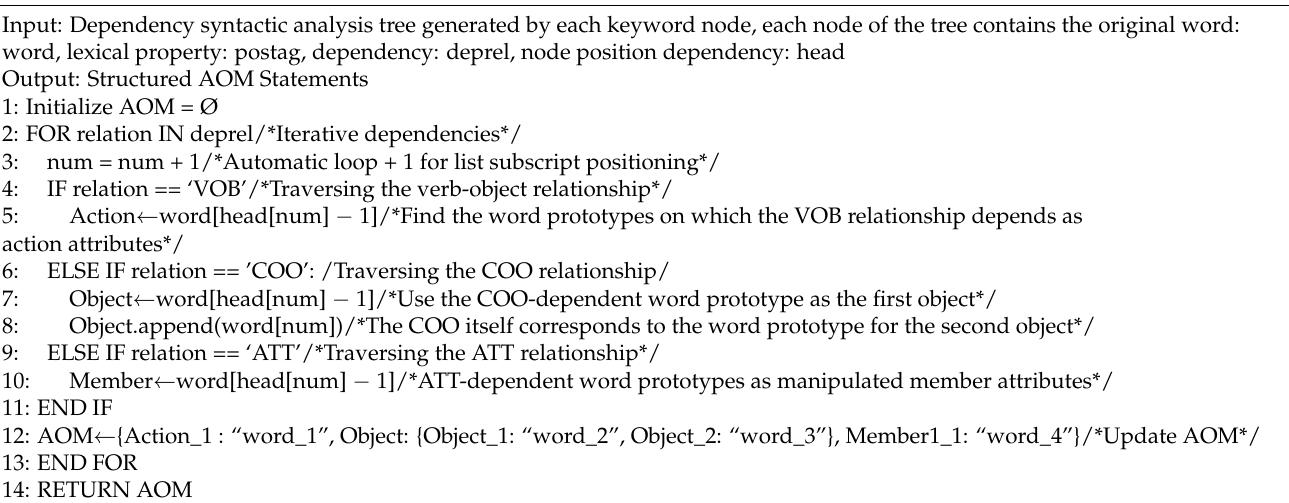
Algorithm 2 Semantic parsing process for the juxtaposition of natural language commands for